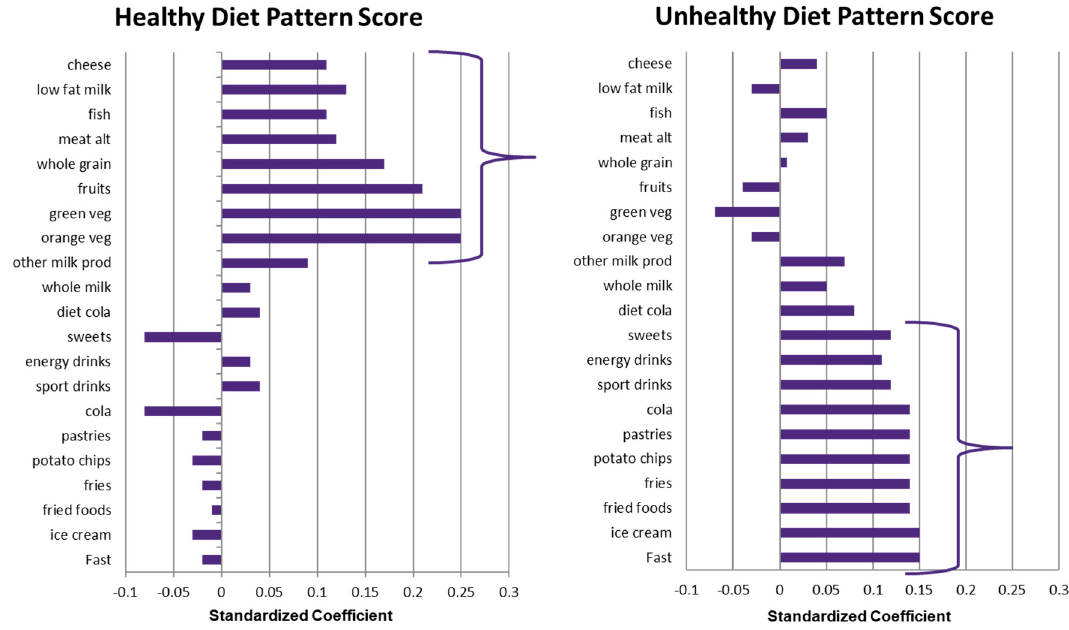
Figure 1. Principal component loadings for the healthy and unhealthy diet pattern scores in the International Study of Childhood Obesity, Lifestyle and the Environment (ISCOLE) (all sites combined), from Mikkila et al.